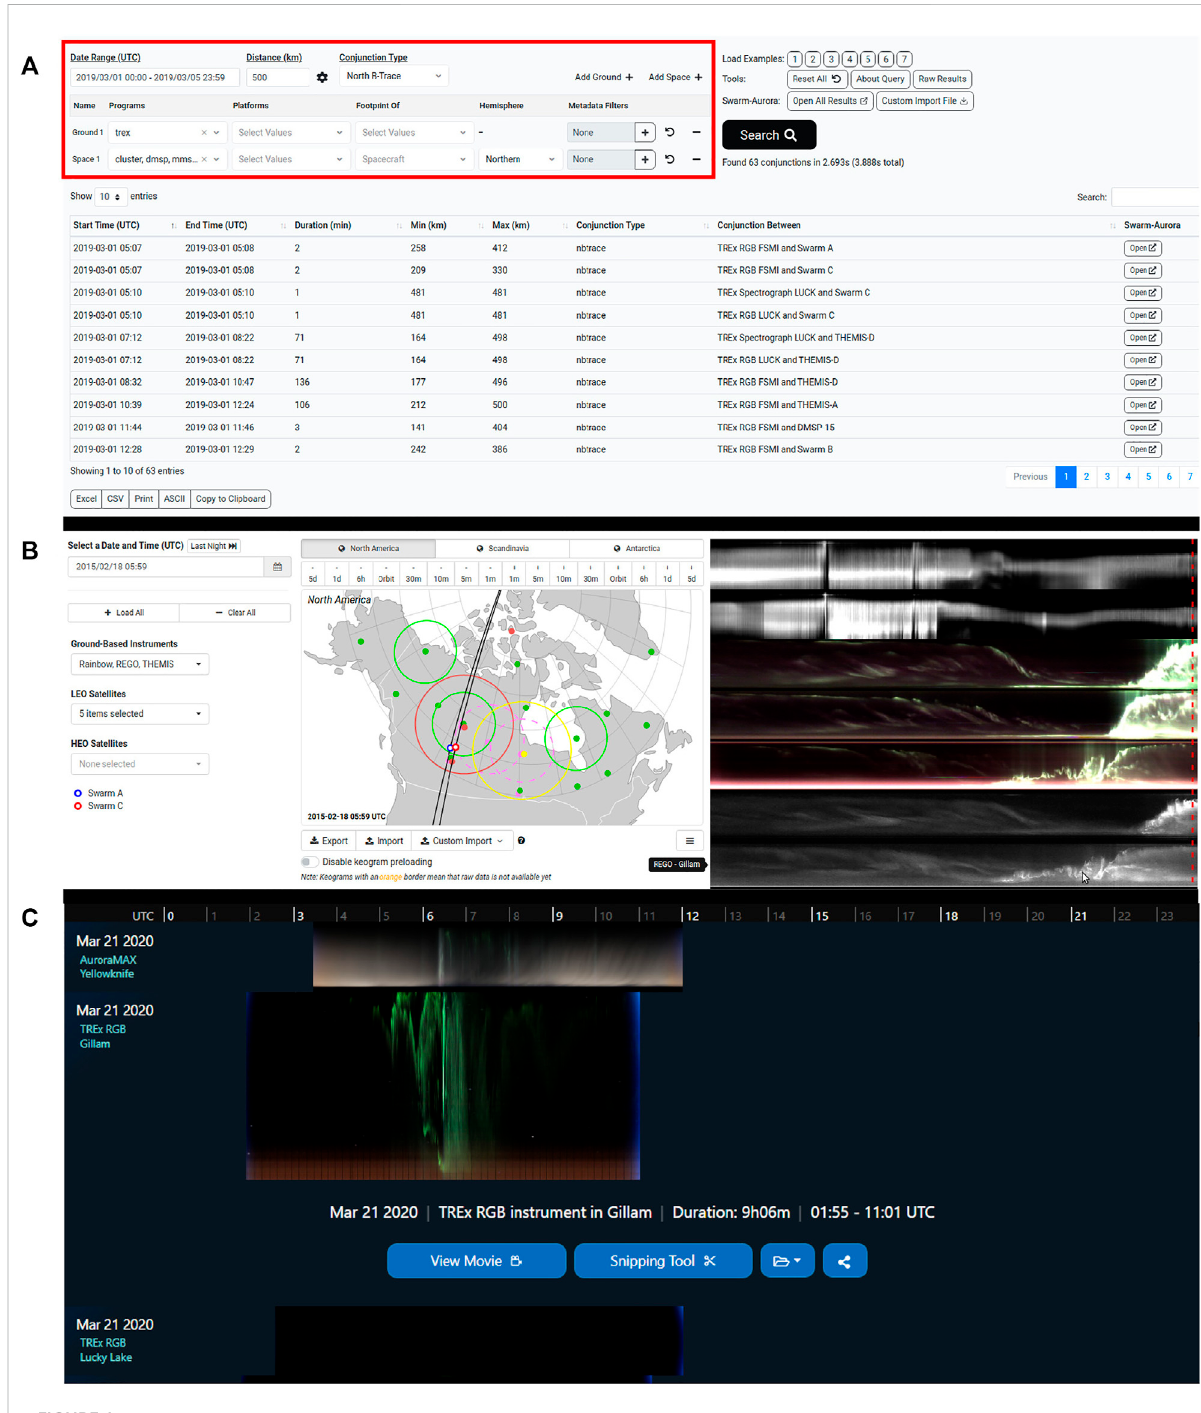
FIGURE 1 The https://aurorax.space/website. Panel (A) shows the conjunction fi nder with the customizable elements highlighted with the red rectangle. Panel (B) shows a detailed view of one of the conjunctions. Lastly, Panel (C) shows the Keogramist for three TREx ASIs on 21 March 2020. The Gillam keogram is expanded to show further